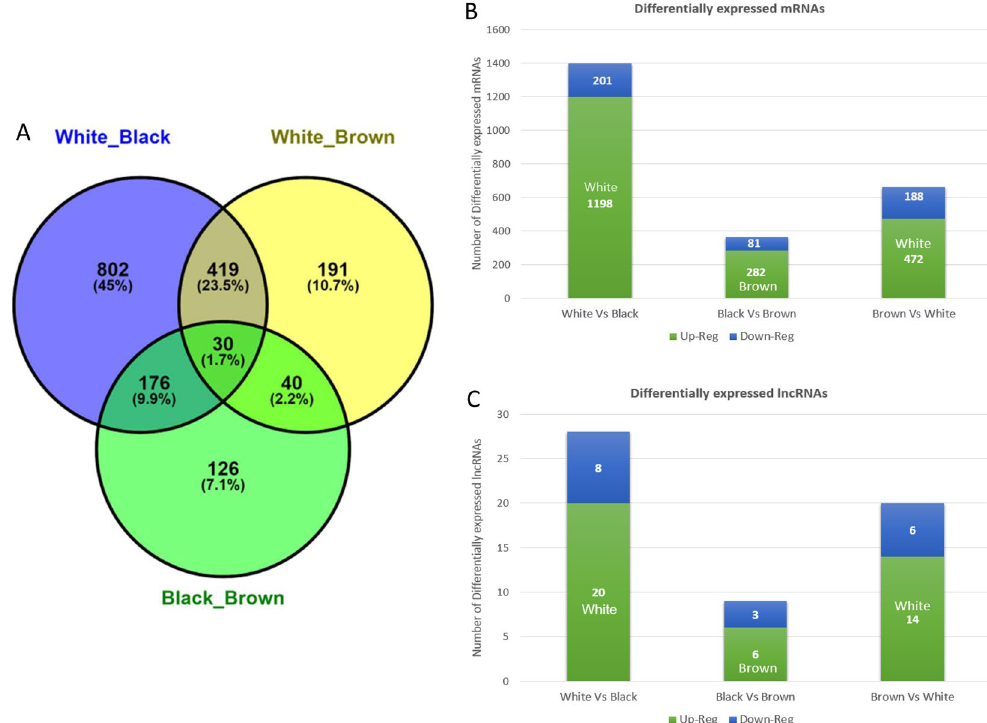
Figure 1. RNA-seq analyses of DEGs in different coat colour of Pashmina fiber. ( A ) Venn diagram representing DEGs between different groups. ( B ) Showing the overlap of differentially expressed mRNA between groups. ( C ) Showing the overlap of differentially expressed lncRNA between